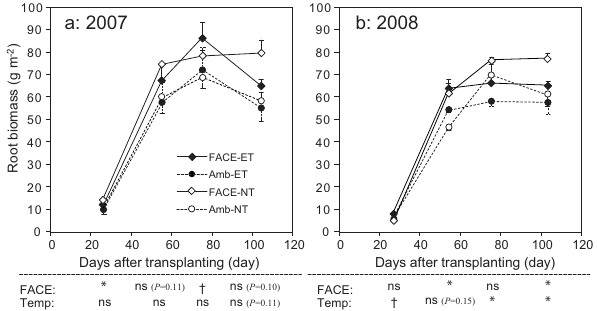
Fig. 2. Changes in CH 4 flux from four treatments plots for two levels of [CO 2 ] and two levels of temperature. Symbols indicate the level of significance of elevated temperature: †, P < 0 . 1; *, P < 0 . 05; **, P < 0 . 01.